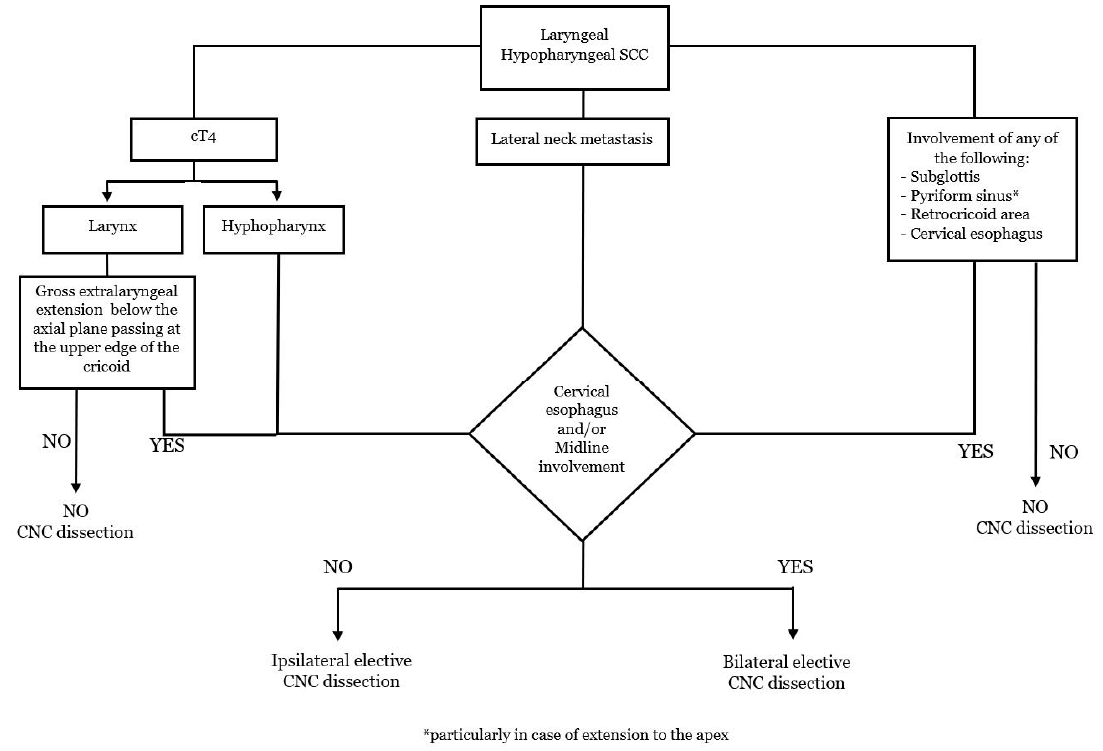
Figure 3. Flow chart: indications for the elective dissection of the